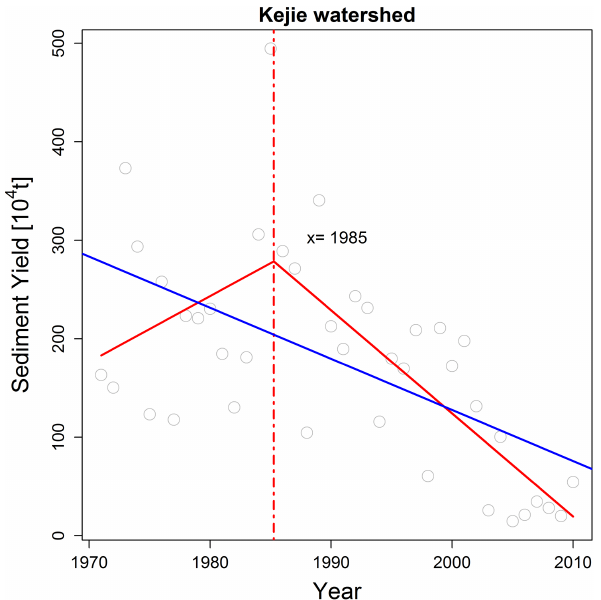
Figure 4. Change trend of suspended sediment yield in the Kejie watershed from 1965 to 2010 (red solid lines are the piecewise- regression lines; the blue solid line is the linear regression line; the red dashed line is to illustrate the breakpoint).